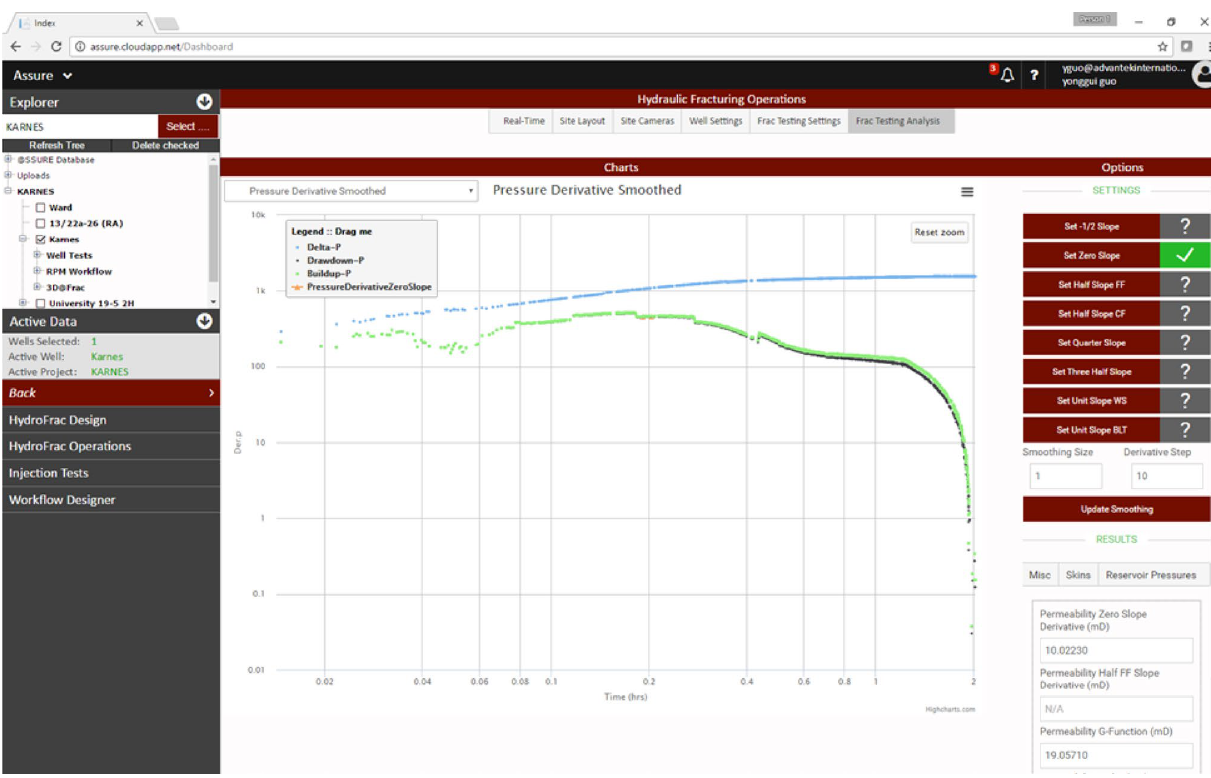
Fig. 9 User interface of the web application for pressure falloff analysis. The pressure falloff analysis is performed in an industry-standard way after each batch injection, which enhances the capability of the web application for real-time injection data